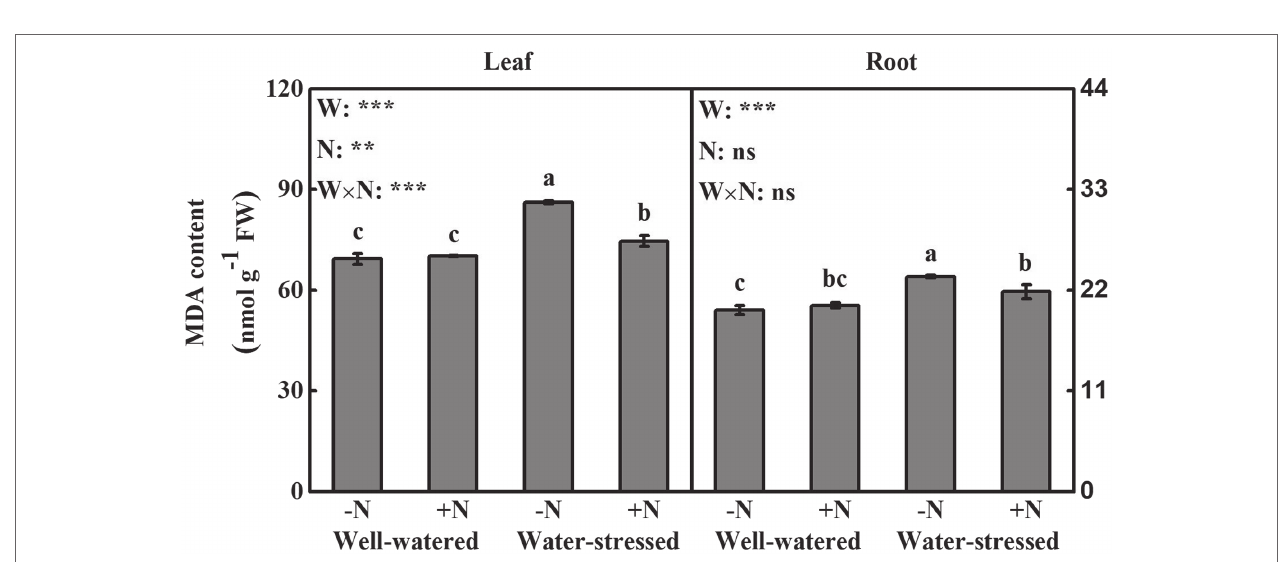
FIGURE 6 | Lipid peroxidation (MDA) of Fargesia denudata leaves and roots for N non-deposition ( − N) and N deposition (+N) treatments with and without drought stress. F W , water effect; F N , N deposition effect; and F W × F N , interactive effect of water and N deposition. Values with different letters are significantly different at p < 0.05. Vertical bars show ± S.E. Significant levels: *** p < 0.001; ** p < 0.01; ns (non-significant) p >